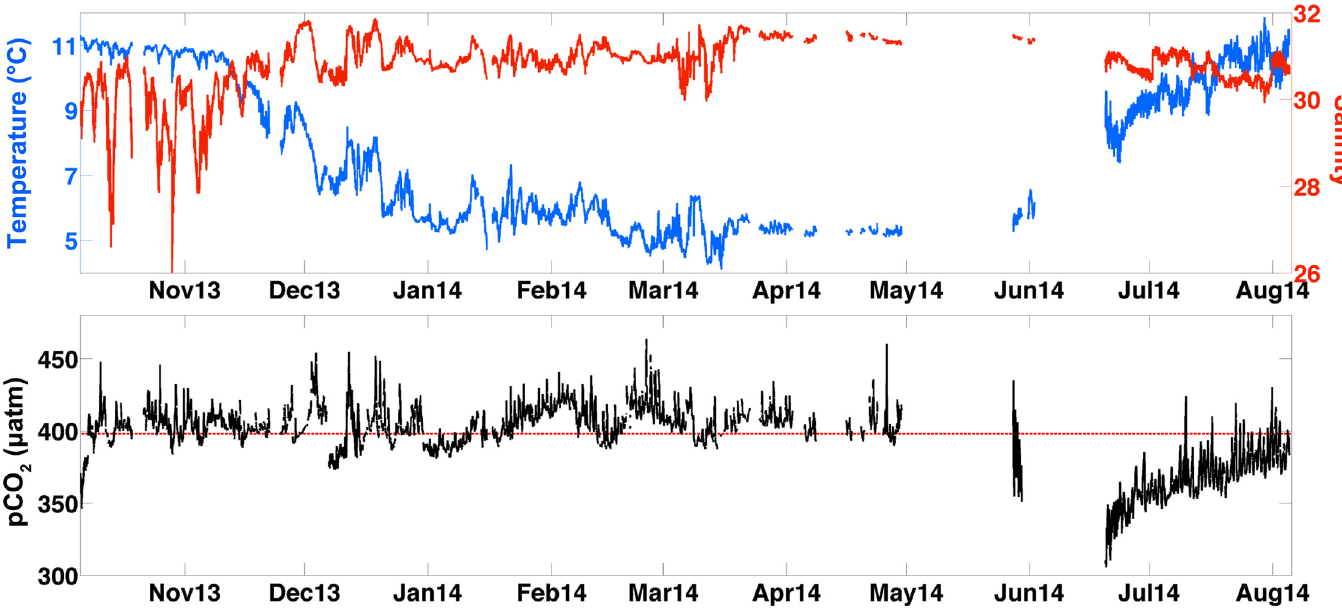
Fig 2. Ten months of data collected from intake water entering the Alutiiq Pride Shellfish Hatchery (APSH). The top panel is temperature (°C; blue) and salinity (red), and the bottom panel is seawater pCO 2 ( μ atm) with the red dashed horizontal line as the mean atmospheric concentration (398 ± 6.7 μ